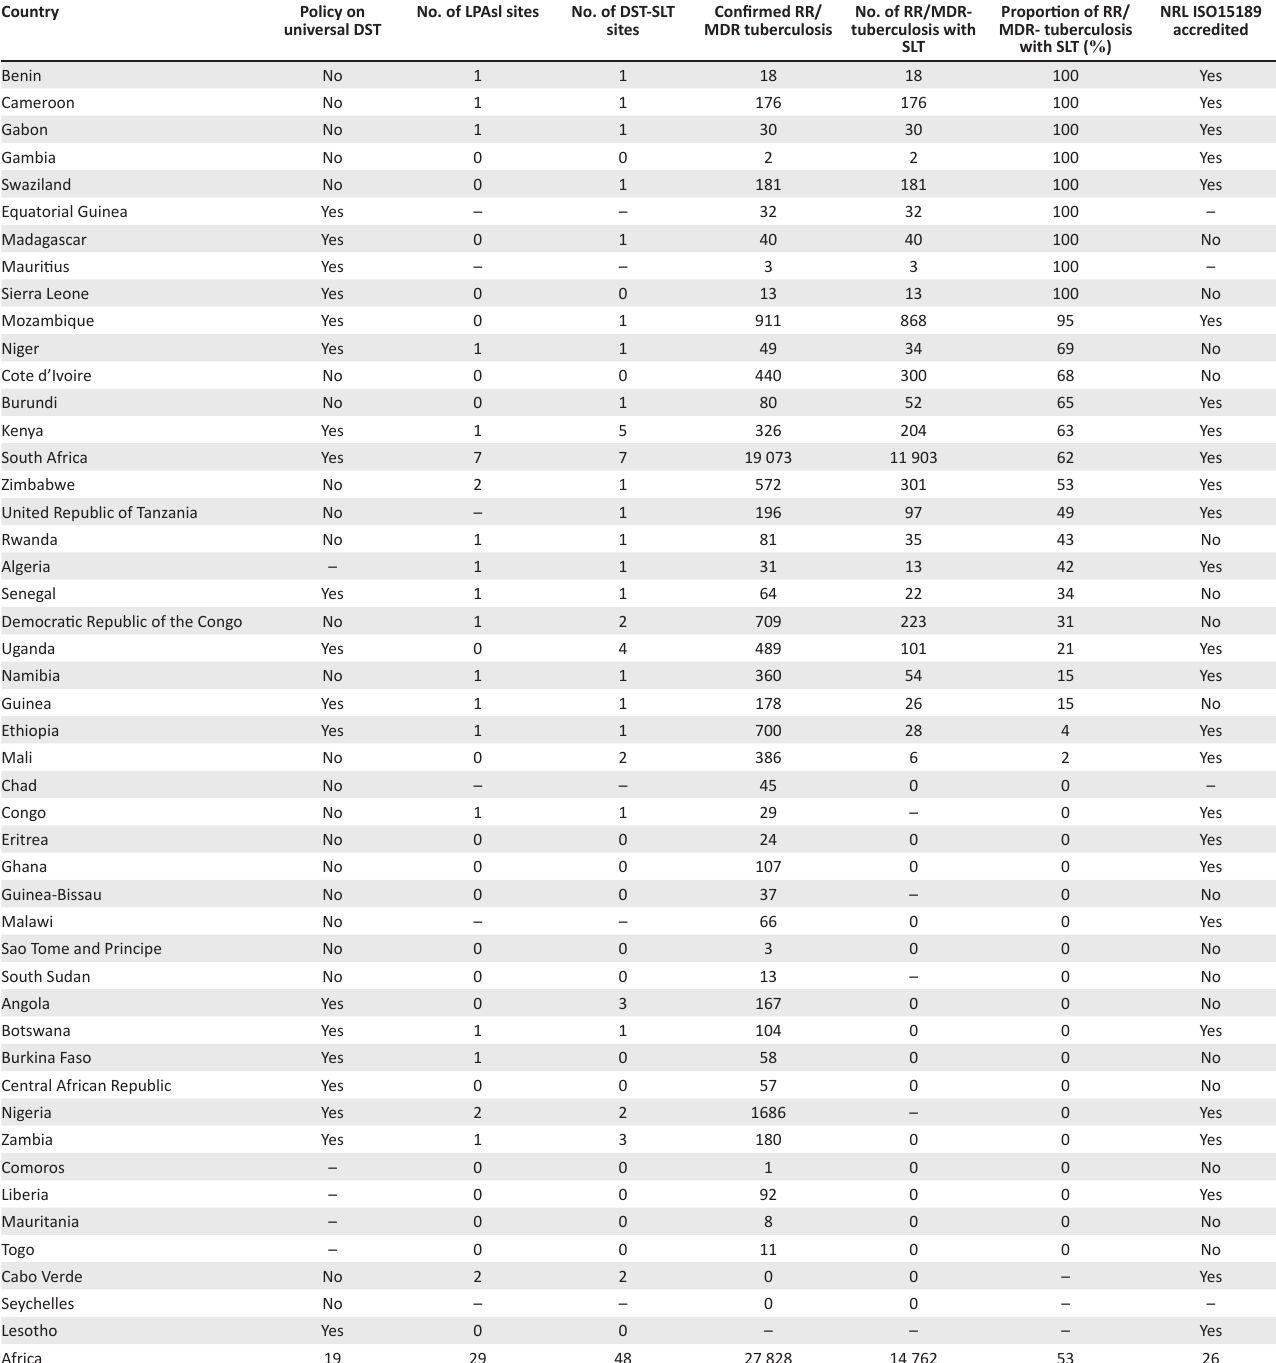
TABLE 3: Second-line resistance detection in Africa from policy to application.